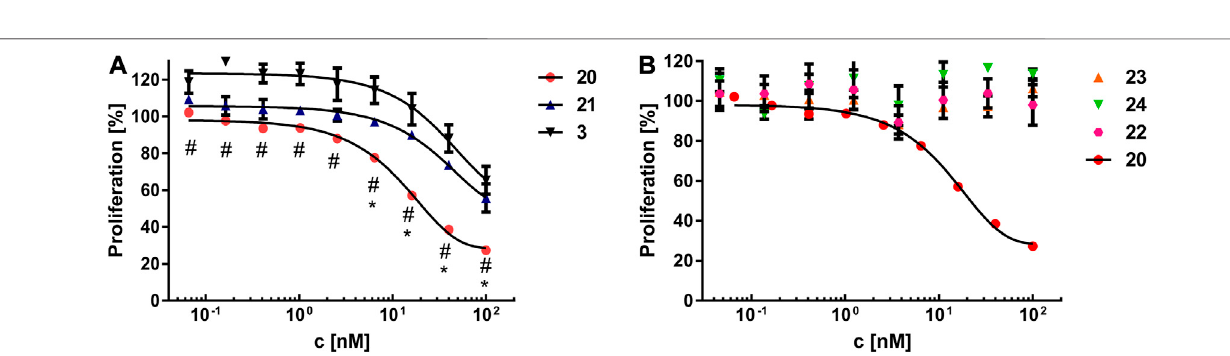
Frontiers in Chemistry |